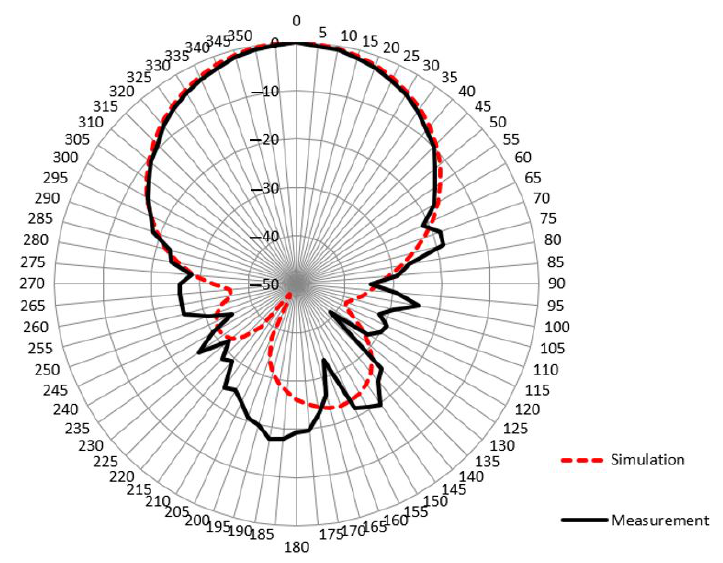
Figure 5. H-plane radiation pattern at 4.148 GHz.